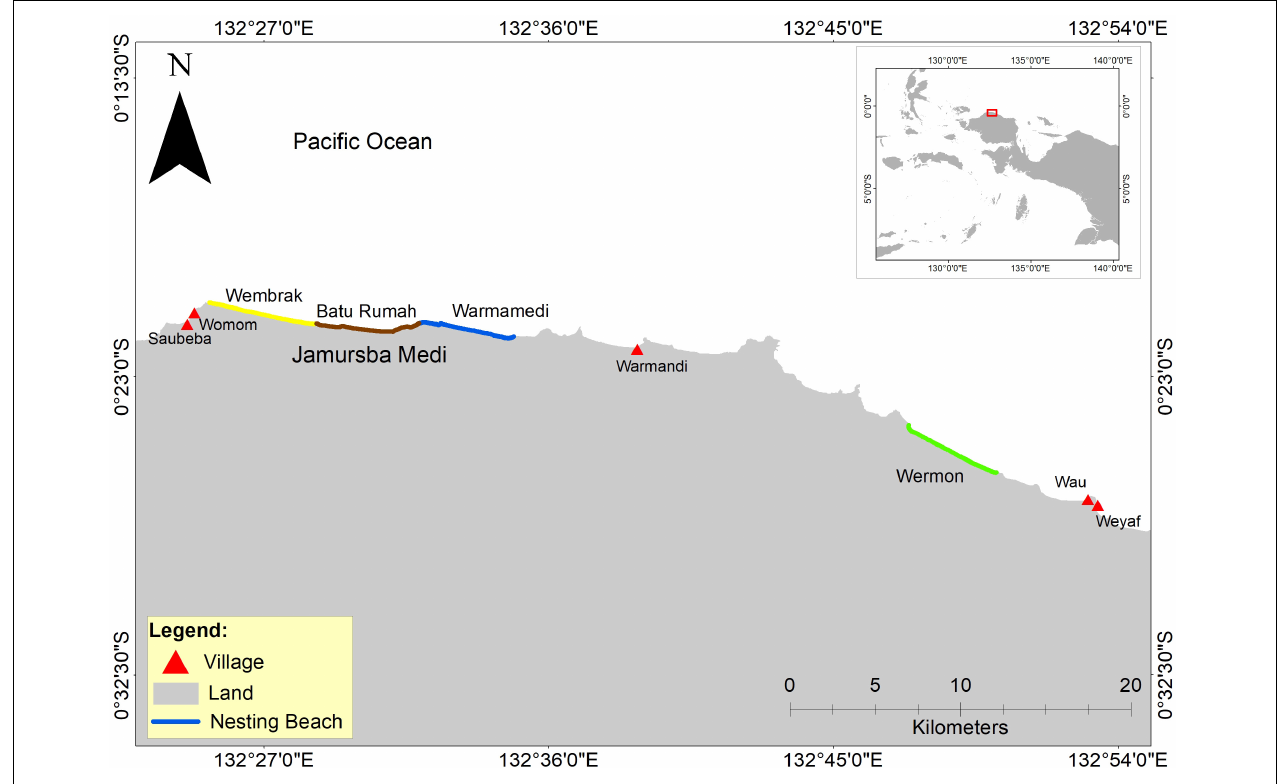
FIGURE 1 | Location of the nesting beaches (Jamursba-Medi and Wermon) and the adjacent villages (Saubeba, Womom, Warmandi, Wau, and